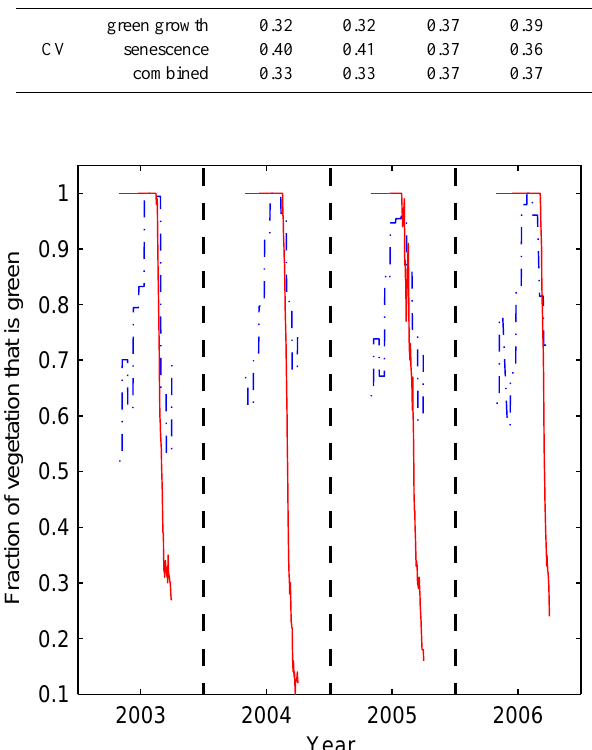
Fig. 4. Fraction of vegetation canopy that is green during the growing season at an agricultural site, BV. Solid line from field observations of LAI, broken line estimated using the VI method.